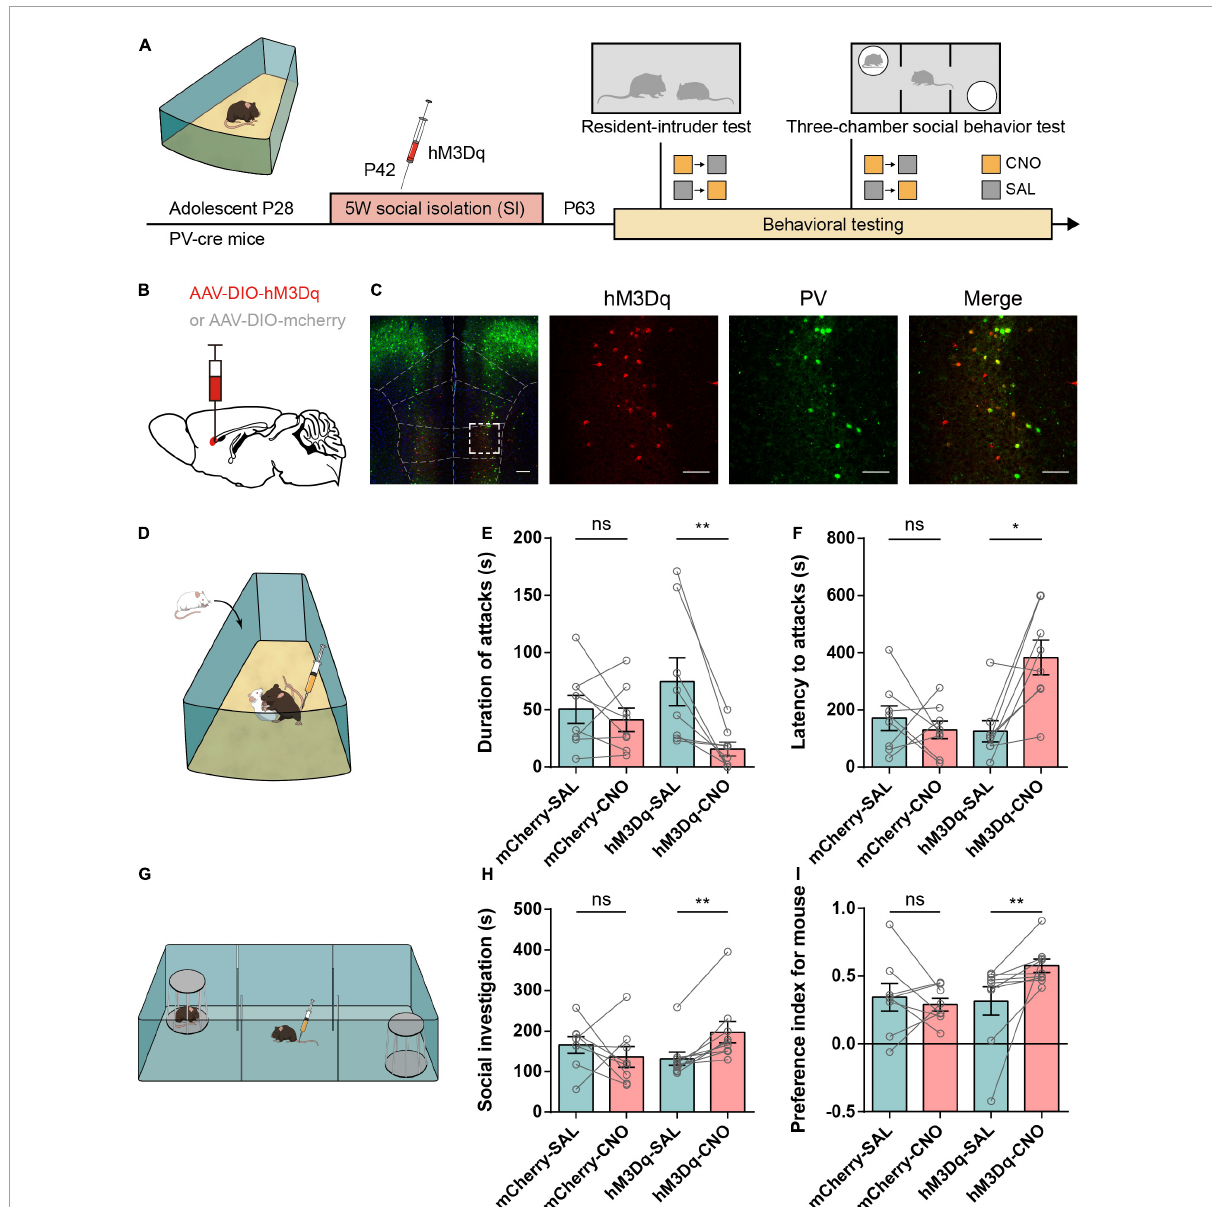
FIGURE5 Activation of IL-PV + interneurons attenuates aggressive behaviors and rescues impaired sociability in adolescent social isolation mice. (A) Experimental design showing adolescent social isolation and a schematic of the injection of the Cre-dependent activation virus hM3Dq into SI PV-Cre mice. Aggression and sociability behavior testing were carried out three weeks later. (B) Strategy of specifically expressing the excitatory G-protein (Gq)-coupled hM3Dq receptor or mCherry in PV + interneurons. (C) Overlay of hM3Dq or mCherry expression in IL PV + interneurons. Immunofluorescent images of a brain slice showing the example location of hM3D (Gq) expression in the IL region (left, scale bar, 200 µ m) and colocalization between hM3Dq (red) and PV staining (green) (right, scale bar, 100 µ m). (D) Experimental scheme for hM3Dq expression in the resident-intruder test. (E,F) Behavioral results from the resident-intruder test for aggressivity show that only the use of CNO in hM3Dq-expressing SI mice decreases the duration of attacks (E) ( n = 8 mice/group, two-tailed paired t test: mCherry, SAL, 50.50 ± 12.20, CNO, 41.25 ± 10.08, P = 0.48; hM3Dq, SAL, 74.69 ± 20.88, CNO, 15.81 ± 6.173, P < 0.01) and increases the latency to attack (F) ( n = 8 mice/group, mCherry, SAL, 171.6 ± 43.55, CNO, 130.6 ± 31.09, P = 0.51 determined by two-tailed paired t test; hM3Dq, SAL, 126.1 ± 37.17, CNO, 383.9 ± 60.42, P < 0.05 obtained by two-tailed Wilcoxon matched-pairs signed rank test). (G) Experimental scheme for hM3Dq activation of IL-PV + interneurons before the 3-chamber test. (H,I) In SI mice, the 3-chamber test for sociability showed that mice treated with hM3Dq showed increases in time spent in social investigation (H) (mCherry group, n = 8 mice, SAL, 165.6 ± 20.83, CNO, 136.4 ± 25.33, P = 0.44 determined by two-tailed paired t test; hM3Dq group, n = 9 mice, SAL, 131.8 ± 16.38, CNO, 197.2 ± 26.74, P < 0.01 determined by two-tailed Wilcoxon matched-pairs signed rank test) and social preference (I) (mCherry group, n = 8 mice, SAL, 0.35 ± 0.10, CNO, 0.29 ± 0.05, P = 0.60 determined by two-tailed paired t test; hM3Dq group, n = 9 mice, SAL, 0.32 ± 0.11, CNO, 0.58 ± 0.05, P < 0.01 determined by two-tailed Wilcoxon matched-pairs signed rank test) only after CNO